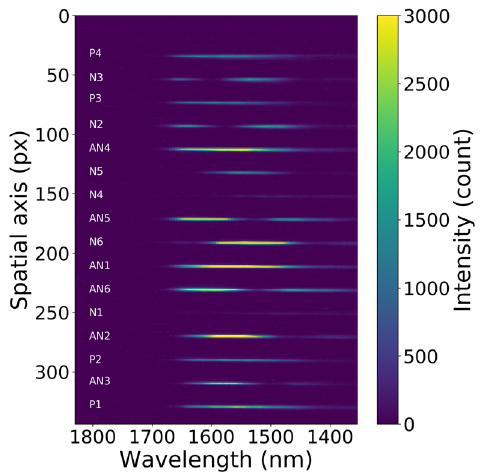
Fig. 5 A data frame from the science sensor illuminated with a laboratory source. Spectral dispersion runs along the horizontal direction, while outputs from different waveguides are displaced in vertical rows. The rows labelled “ P ” are the photometric tap. “ N1-6 ” are the outputs corresponding to the null output and “ AN1-6 ” are the outputs corresponding to the respective anti-null outputs. On this occasion, pistons on the MEMS mirror were con fi gured to produce a nulled signal on N1 and